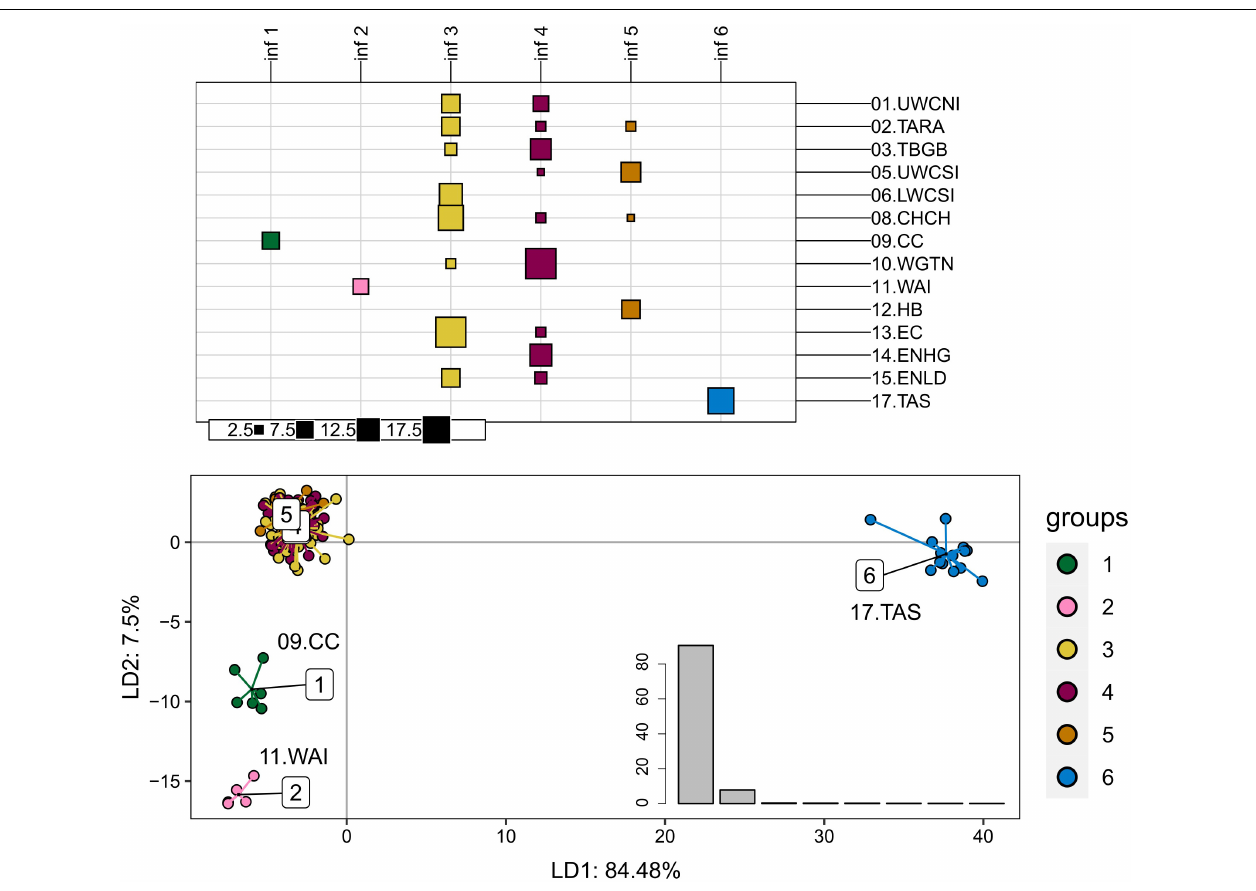
FIGURE 6 | Discriminant analysis of principal components of the first adaptive SNP datasets that include 389 loci from 165 tarakihi. Top: results of the K- means clustering analysis. All individuals were clustered into k = 6 inferred groups ( inf , in columns) based on genetic variation regardless of their sample location (rows). Size of squares corresponds to the number of individual samples. Bottom: Projection of the DAPC based on inferred groups. Bottom right: Discriminant analysis eigenvalues. Colors of groups (top and bottom) correspond to the inferred K -means clusters (inf 1-6, top). Sampling location codes as referred to in Table 1